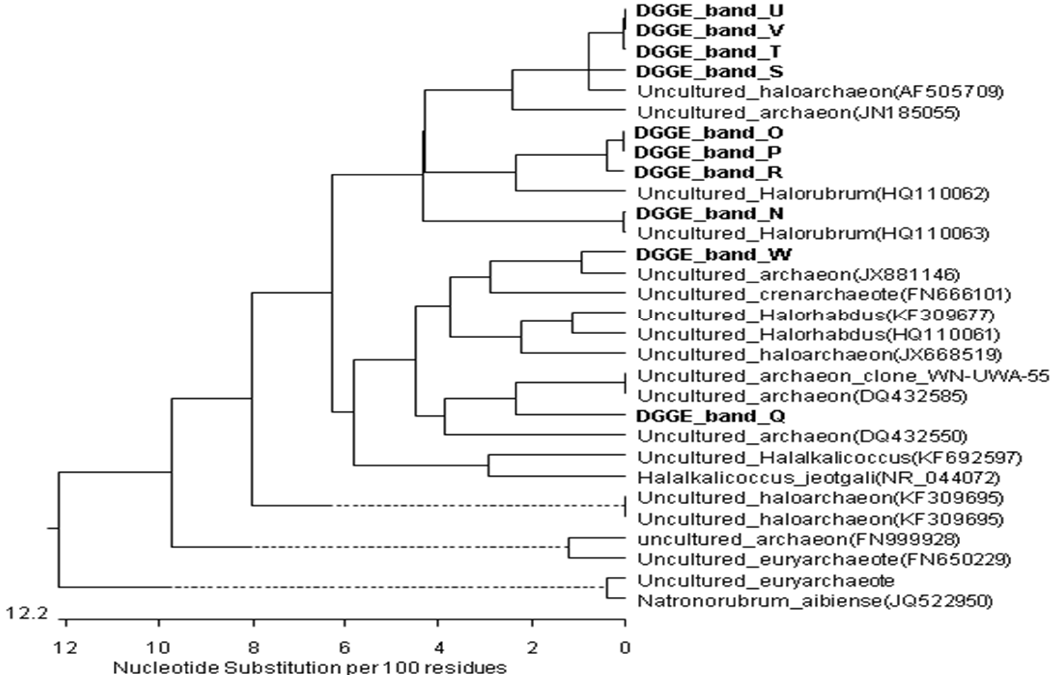
Figure 4. Phylogenetic tree showing the relationships of archaeal 16S rRNA gene sequences of excised DGGE bands to closely related (S ≥ 90%) sequences from the GenBank database.